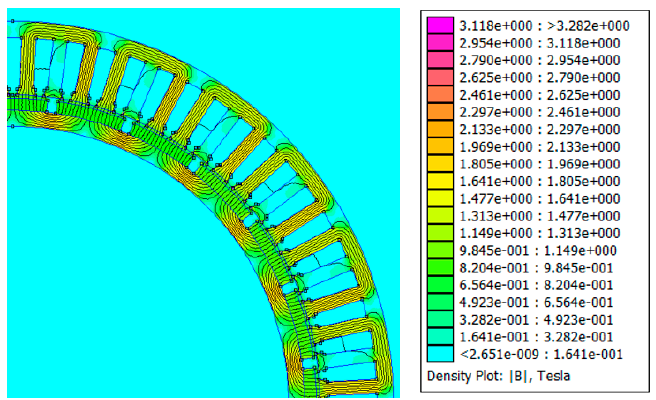
Figure 10. 2D magnetic flux density and vector potential in PMSG’s optimized structure. Table 5. The mass and cost of reference and optimized